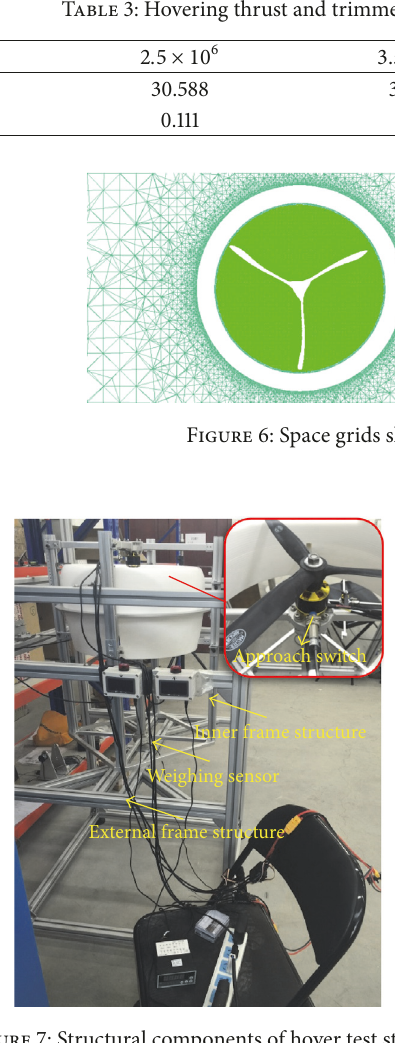
Figure 7: Structural components of hover test stand.